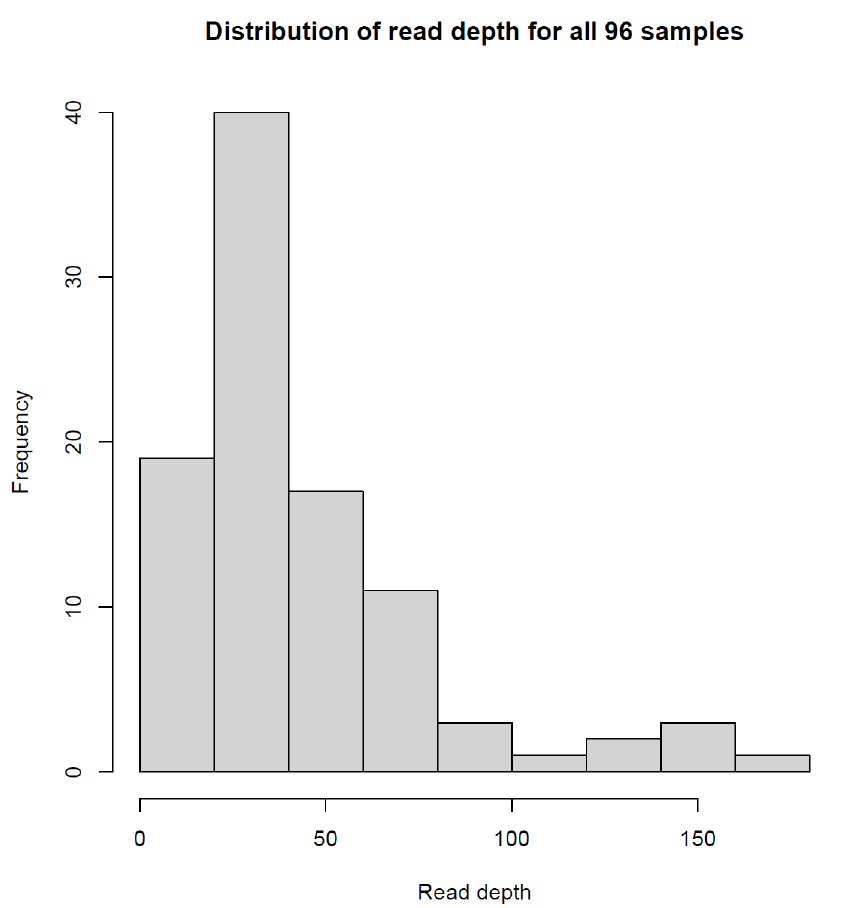
Figure A1. Graph presenting distribution of mean read depth for all 96 samples genotyped using 9315 SNPs with a GBS approach. In the x -axis, read depth data including primary and secondary alle- les are presented. In the y -axis, the frequency of samples with corresponding read depth is